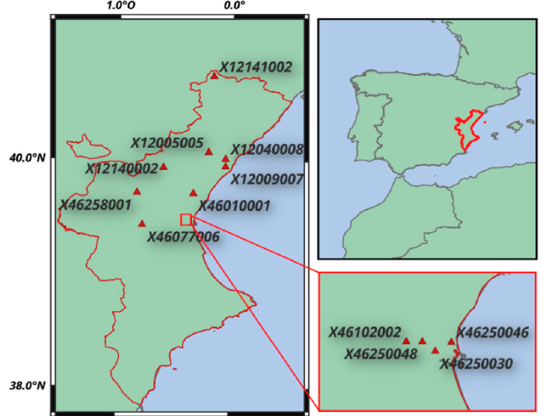
Figure 1. Valencian Community and the PM 2.5 monitoring